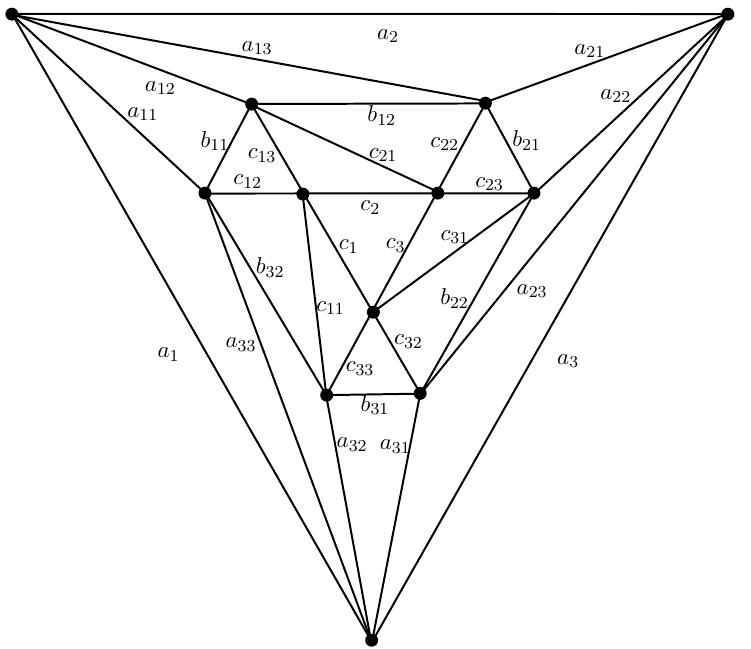
Figure 11: Denotations: ( a i )( a ij )( b ik )( c ij )( c i ) , i = 1 , 2 , 3 ; j = 1 , 2 , 3 ; k = 1 , 2 .